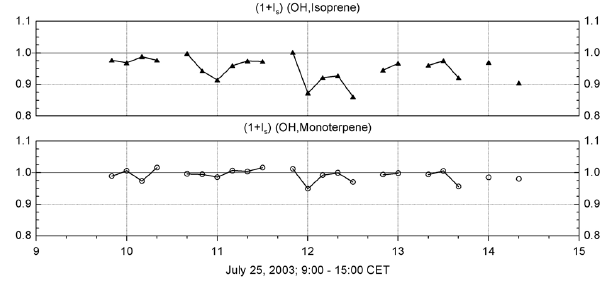
Fig. 10. Term (1+ I s ) according to Eq. 6 for OH and isoprene, and OH and the sum of monoterpenes.